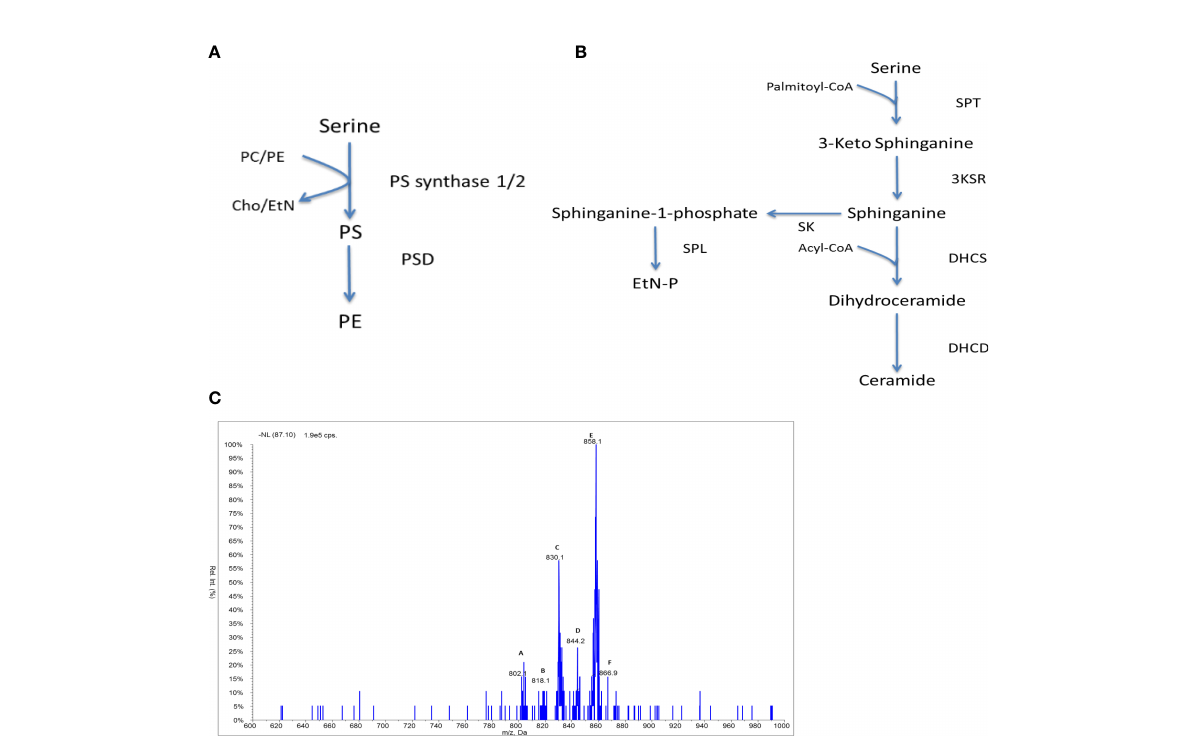
FIGURE 5 Serine lipid metabolism in Crithidia: An overview of (A) PS synthesis in eukaryotes, (B) ceramide synthesis in kinetoplastids. Key - 3KSR, 3- Ketosphinganine reductase; DHCD, Dihydroceramide desaturase; DHCS, Dihydroceramide synthase; PSD, Phosphatidylserine decarboxylase; SK, Sphingosine kinase; SPL, Sphingosine-1-phosphate lyase; SPT, Serine palmitoyltransferase; Cho, Choline; EtN, Ethanolamine; EtN-P, ethanolamine phosphate; PC, phosphatidylcholine; PE, phosphatidylethanolamine; PS, phosphatidylserine. (C) ESI-MS-MS neutral loss scan of PS lipids from C. fasiculata lipid extract, scanning for m/z 87 in the negative mode. Peaks are plotted as their relative intensity (%) to that of the largest peak in the spectrum and in terms of their mass to charge (m/z) ratio. (Species identi fi cation in Table